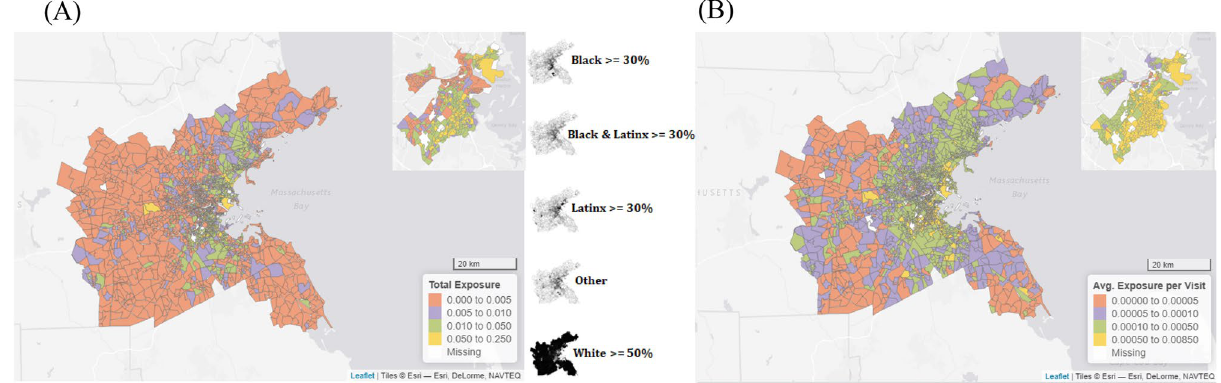
Figure 3. Communities of color experienced ( A ) more exposure to infection through visits to grocery stores and ( B ) more exposure per grocery store visit, especially in Boston proper (see insets; made with leaflet package in R 52